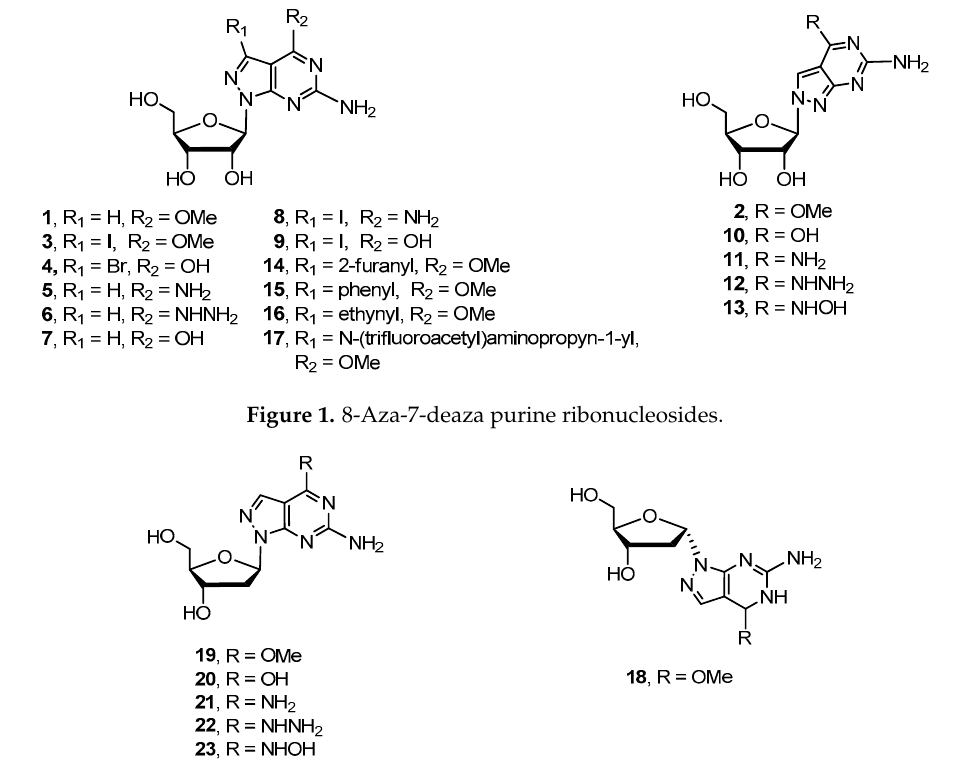
(cid:48) -deoxy purine Figure 2. 8-Aza-7-deaza-2 ′ -deoxy purine nucleosides. Figure 2. 8-Aza-7-deaza-2 Figure 2. 8-Aza-7-deaza-2 ′ -deoxy purine nucleosides.